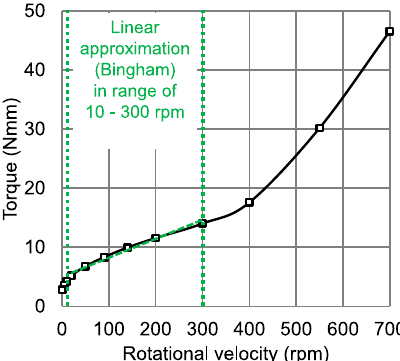
Figure 4. Typical results for torque as a function of rotational velocity, representative for all samples investigated with the Bingham approximation in the range of 10–300 rpm with regression coe ffi cient (R 2 =